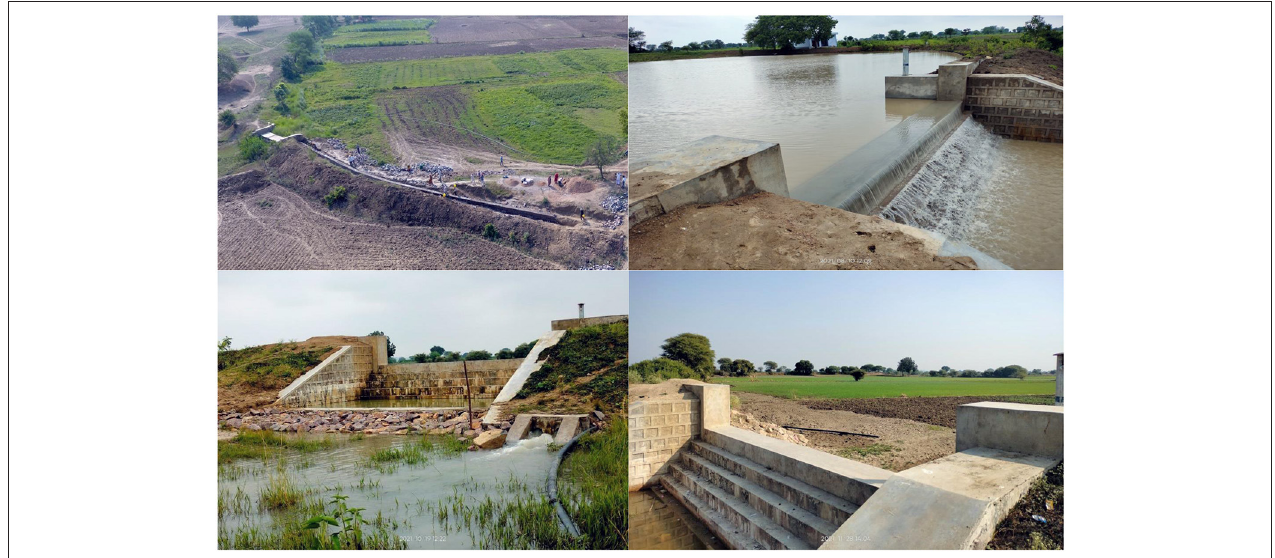
FIGURE 2 | Construction of masonry core wall and spillway ( top left ); Harvested rainwater in haveli structure during monsoon period ( top right ); draining out water from haveli before post-monsoon crop ( bottom left ); wheat crop cultivated on haveli bed during post-monsoon season ( bottom right ).